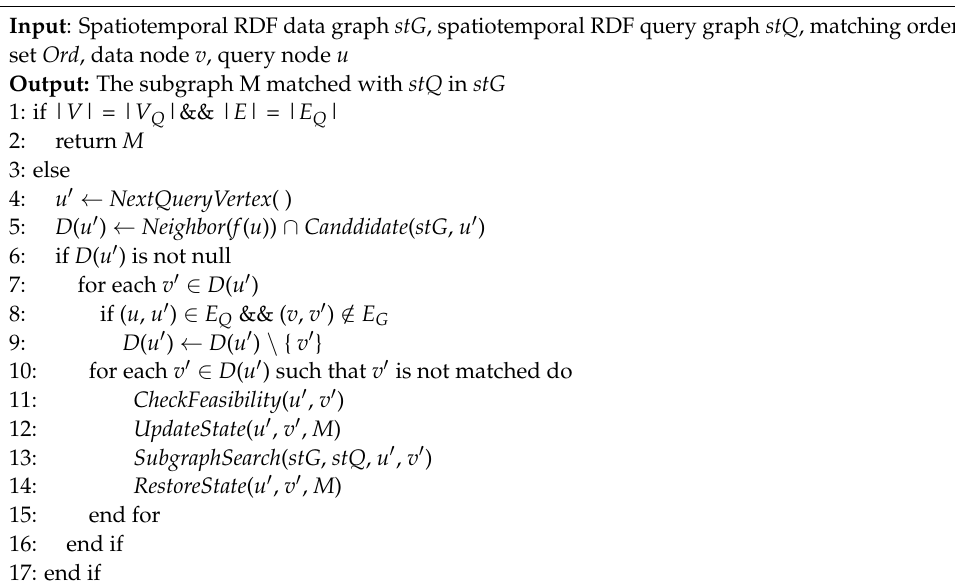
Algorithm 3: Subgraph Matching Algorithm